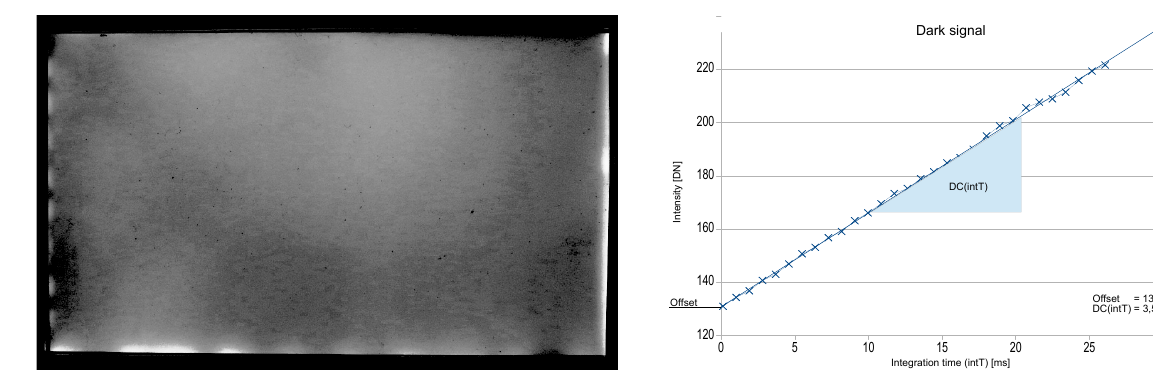
Figure 1: Photo of the complete LED backlight. For better visu- alization the contrast is exaggerated.